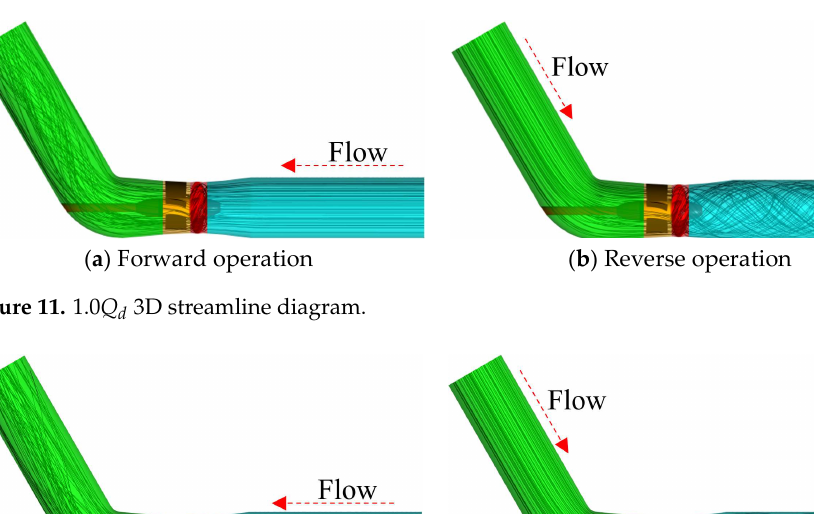
Figure 10. 0.9 Q d 3D streamline diagram.